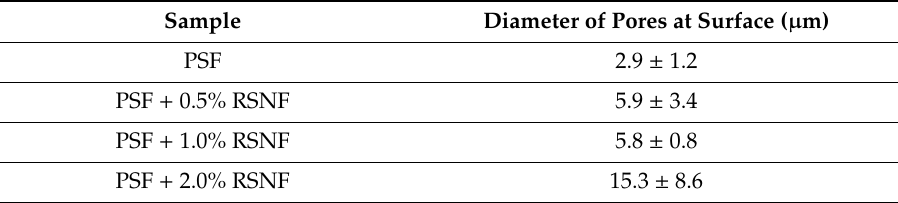
Figure 2. SEM of cross-section of polysulfone membranes with different RSNF loadings. Table 2. Diameter of pores at the surface of PSF / RSNF